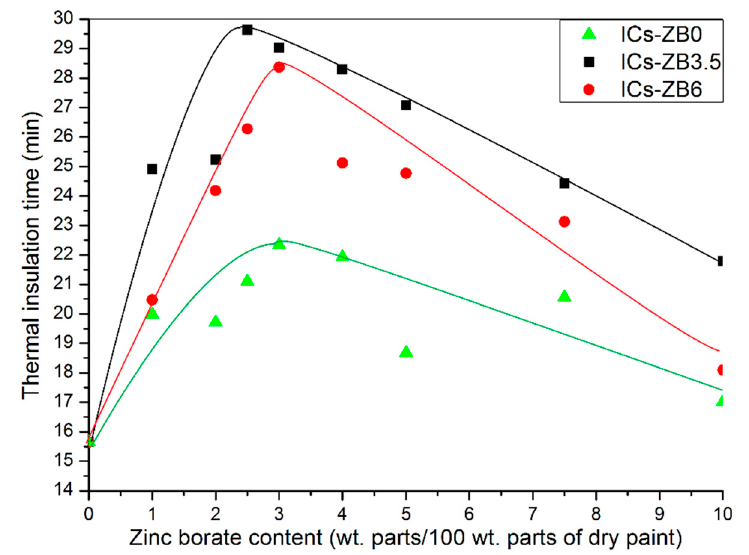
Figure 3. Thermal insulation time for the intumescent coatings as a function of zinc borate content.